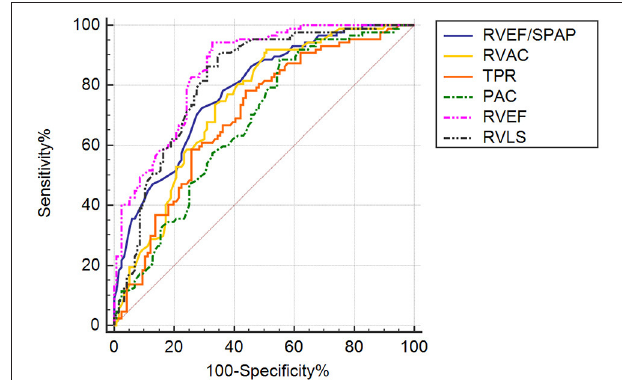
FIGURE 4 | ROC curve analysis of RV function indices and RV coupling to pulmonary circulation in patients with precapillary PH. AUC, area under the curve. ROC curve analysis demonstrating the abilities of RVEF/PASP, RVAC, TPR, PAC, 3D RVEF, and RVLS to predictive adverse clinical outcomes in PH